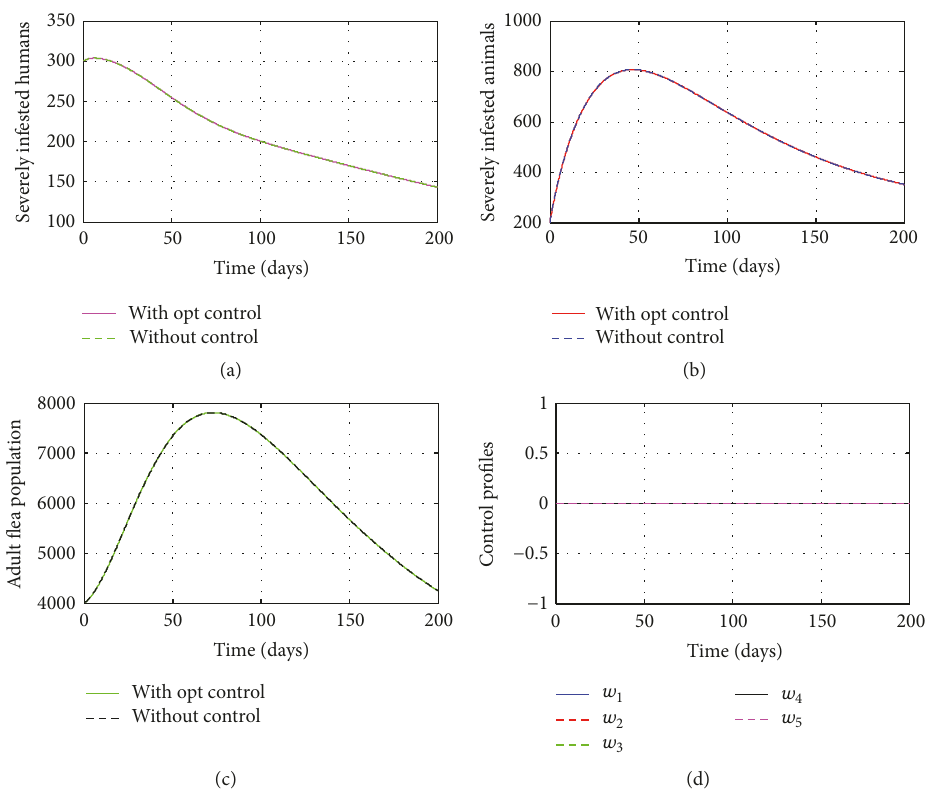
Figure 2: Simulations of model variables 𝐼 𝐻ℎ , 𝐼 𝐴ℎ , 𝐹 𝐸 without